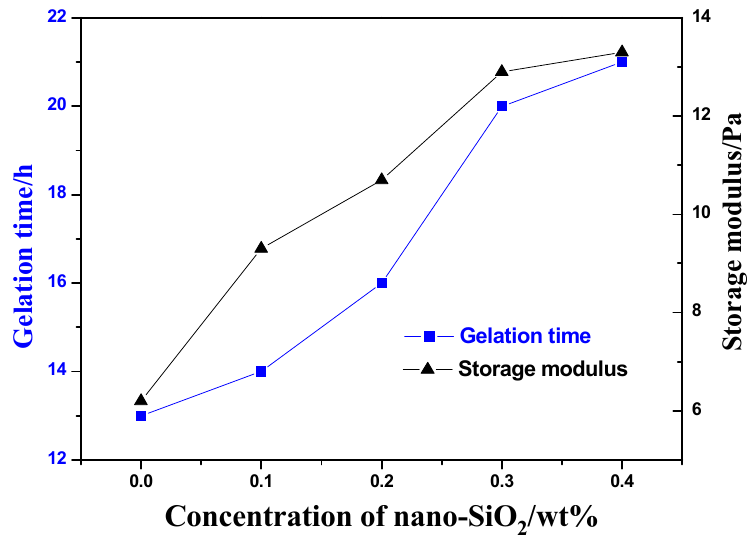
Figure 5. Gel strength and thermal stability of different concentrations of Nano-SiO 2.